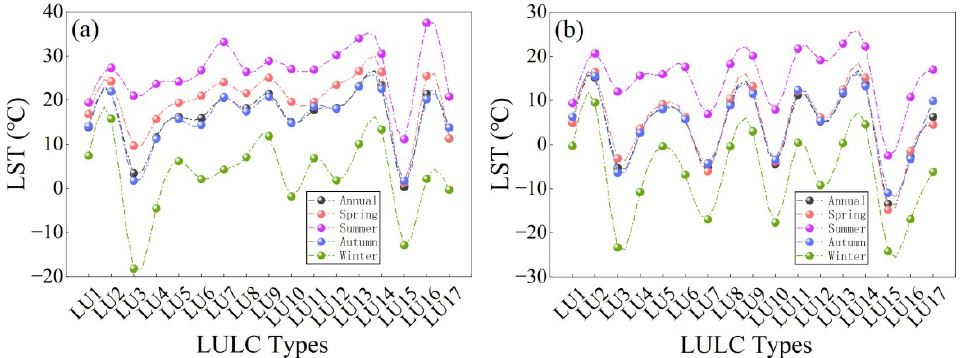
Figure 4. Mean land surface temperature (LST) values of different land use/land cover (LULC) types in the daytime and nighttime, in each season and annually. LU1–LU17 represent evergreen needleleaf forests, evergreen broadleaf forests, deciduous needleleaf forests, deciduous broadleaf forests, mixed forests, closed shrublands, open shrublands, woody savannas, savannas, grass- lands, permanent wetlands, croplands, urban and built-up lands, cropland/natural vegetation mosaics, permanent snow and ice, barren land, and water bodies, respectively. ( a ) Daytime; ( b ) nighttime. Table 3. Mean land surface temperatures (LSTs) of different land use/ land cover (LULC) types in the day and night, in each season and annually.